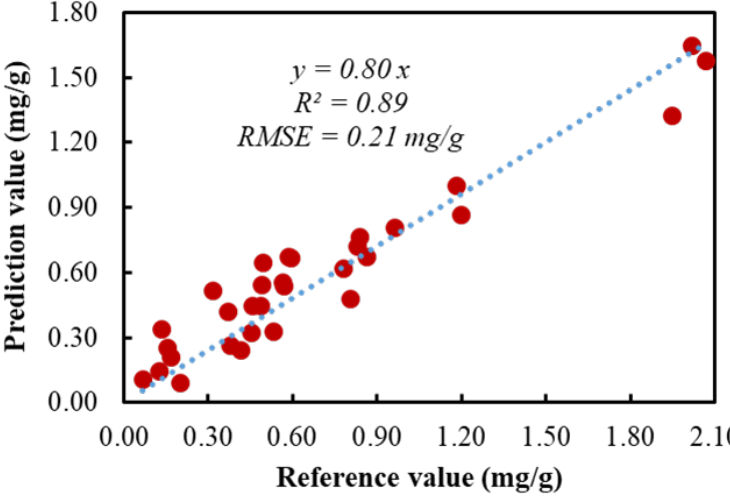
Figure 5. Anthocyanins prediction for every seed of the four examined rice varieties. The average and the broadest error between mean prediction and reference values were 0.16 and 0.49 mg/g, respectively. The RSME value was 0.21 mg/g, slightly higher than the SEP value of the model of 0.16 mg/g. Among thirty-two varieties, only seven varieties revealed an error higher than the RMSE value, and four of them were varieties with high anthocyanin concentration (more than 1 mg/g). In this experiment, only six varieties contained anthocyanins concentrations of more than 1 mg/g, which possibly affected the model’s development. The prediction plot for all varieties is presented in Figure 6.